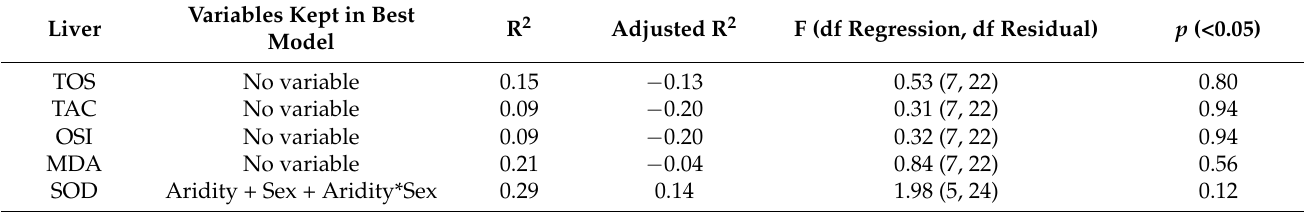
Table 2. The linear best model output for liver oxidative markers, namely total oxidant status (TOS), non-enzymatic total antioxidant activity (TAC), oxidative stress index (OSI), malondialdehyde (MDA) and superoxide dismutase (SOD), for the common mole-rat ( Cryptomys hottentotus hottentotus ) in response to body mass, age, aridity, sex and the interaction between sex and aridity determined through backwards elimination based on the Akaike information criterion.